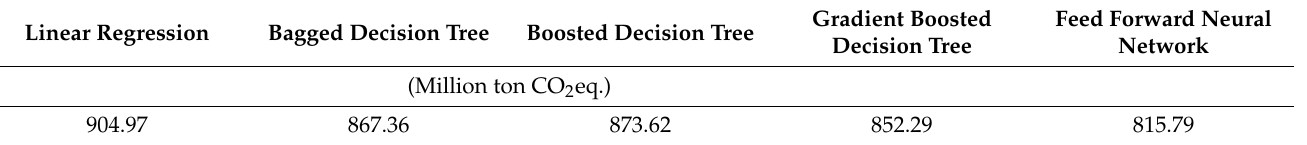
Figure 7. Predicted GHG emissions up to 2040 employing various decision tree models. Table 3. DT-based AI model projected GHG emissions in 2040 for Saudi